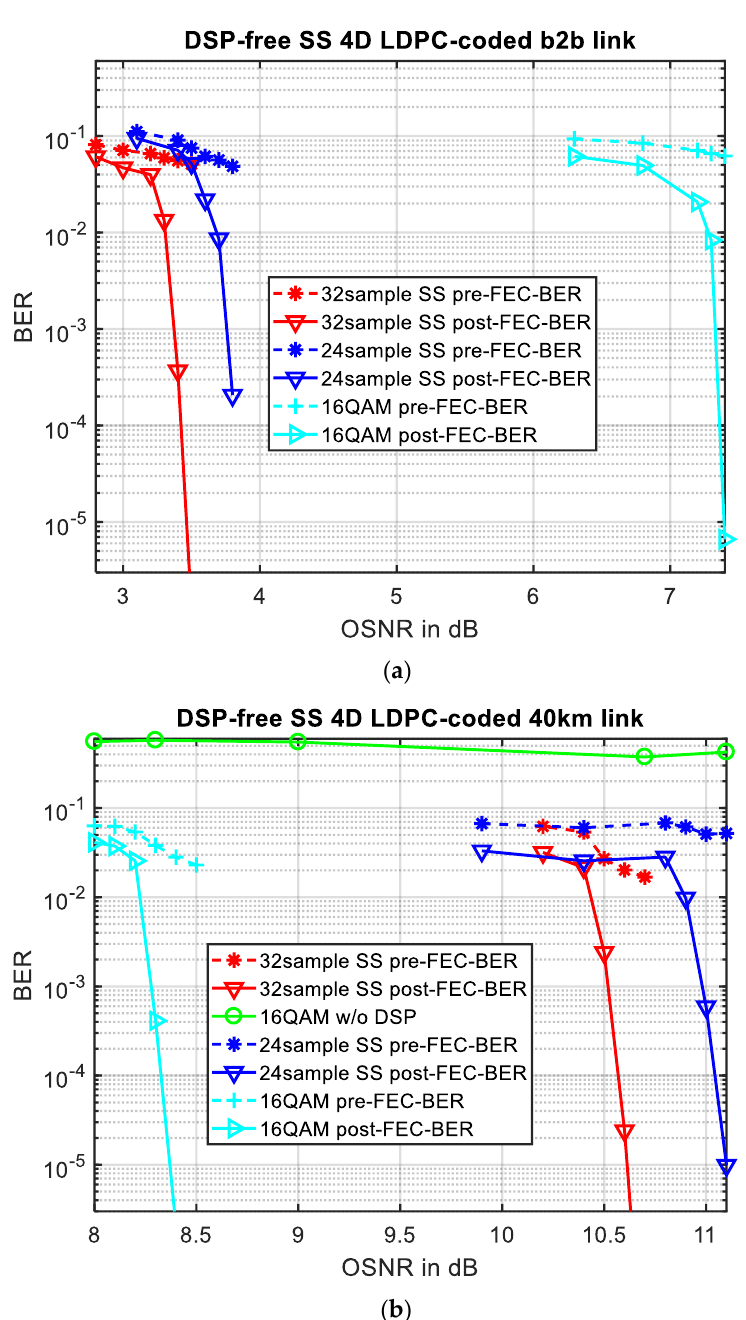
Figure 7. BER performance over OSNR for 32 and 24 samples SS 4D modulation and regular 16QAM with and without DSP: ( a ) in the back-to-back configuration and ( b ) after 40 km SMF link transmission.